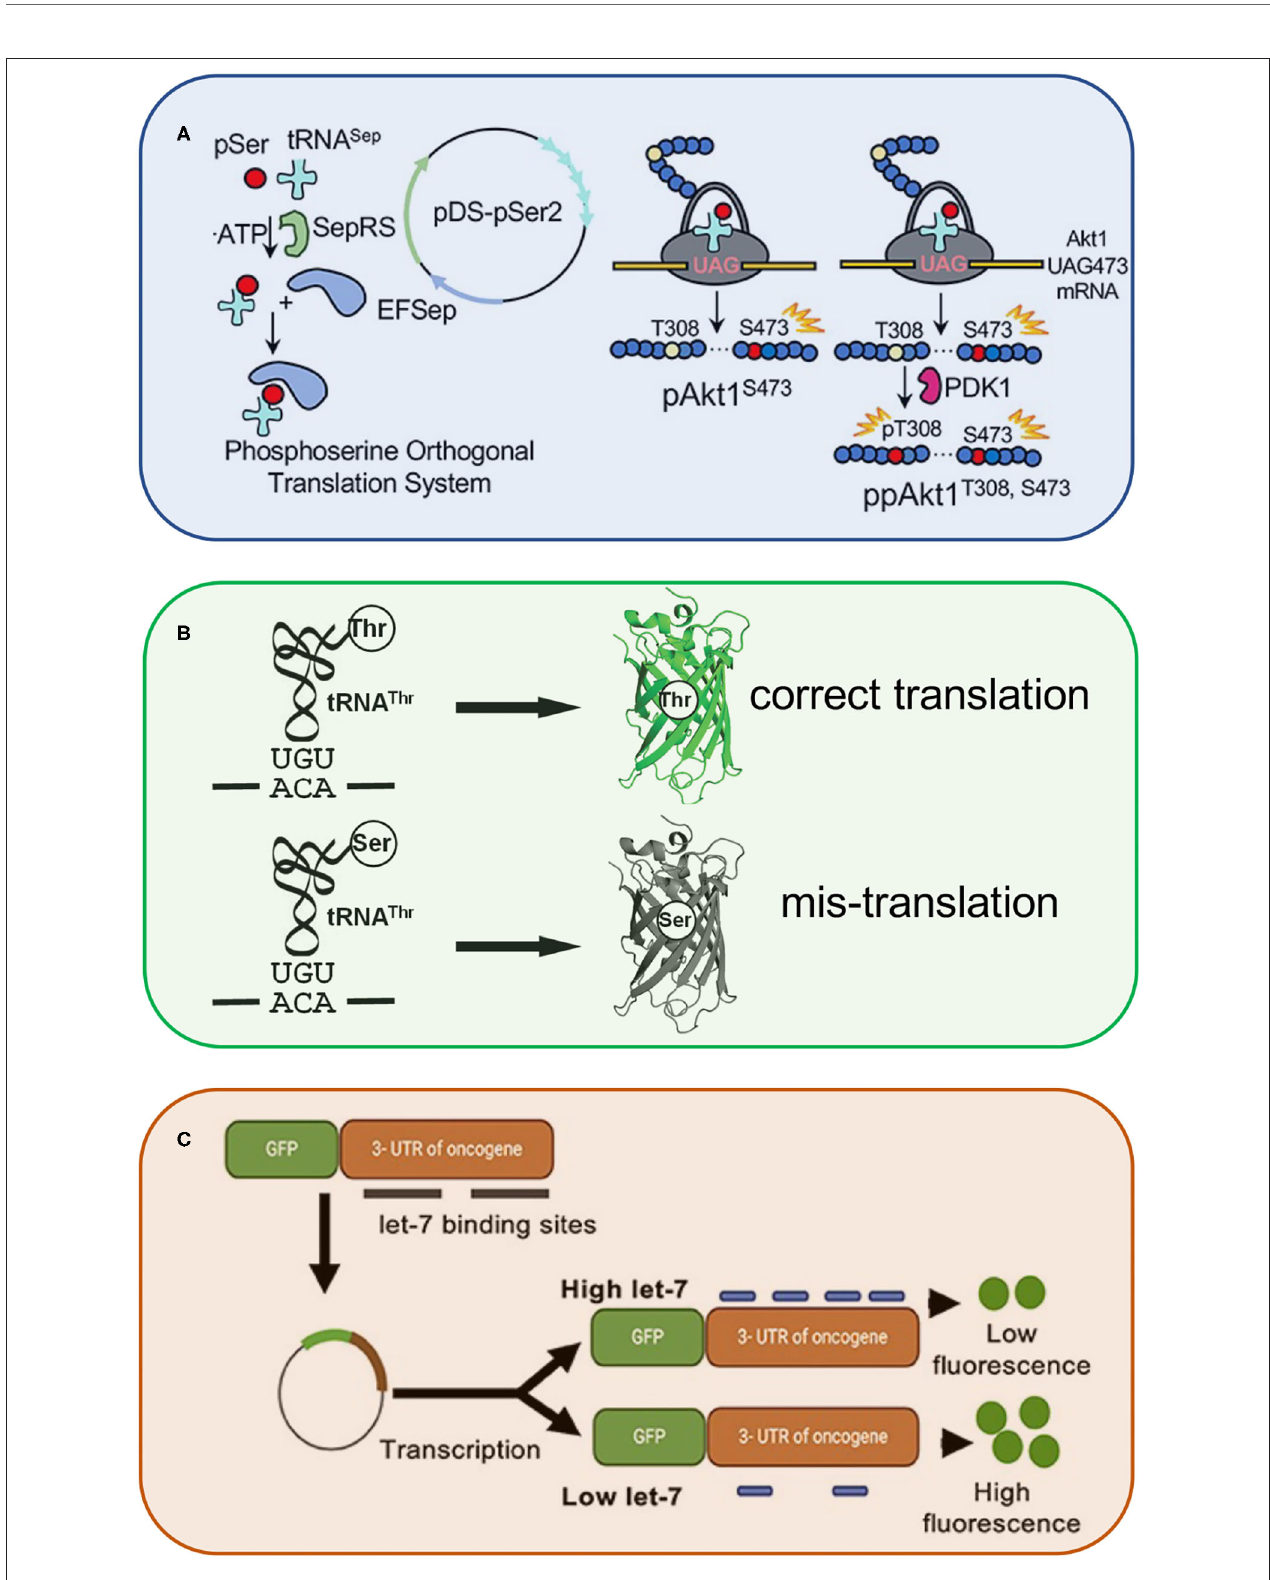
FIGURE 1 | Synthetic and engineered RNAs for genetic code expansion and probing living cells. The schematic highlights a few of the innovative technologies described in this special issue. These include engineered transfer RNAs (tRNA Sep ) to enable genetic code expansion and applications such as the production of active human kinases (A) . In addition, this special issue highlights novel reporters of RNA activity, including green fluorescent protein reporters sensitive to either tRNA-dependent amino acid mis-incorporation (B) or microRNA activity (C) .